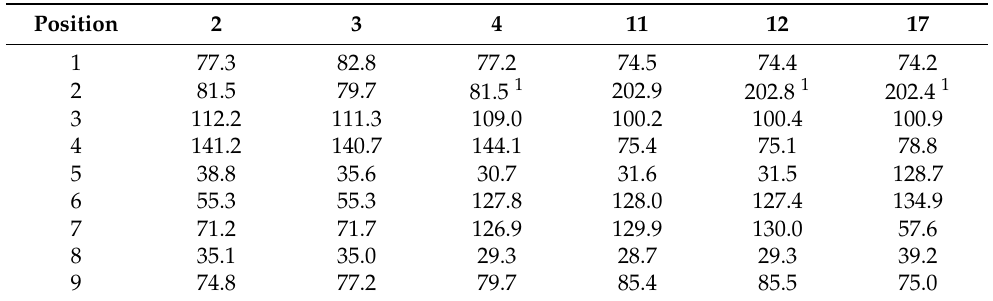
Table 1. 13 C NMR ( δ in ppm) data of compounds 2 , 3 , 4 , 11 , 12 and 17 recorded at 50.3 MHz in CDCl 3 .